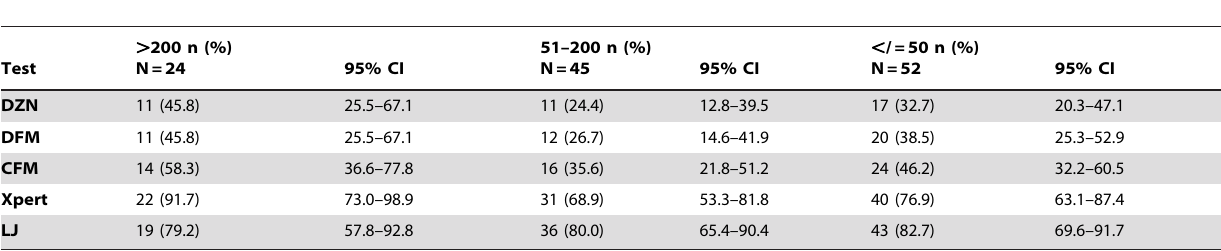
Table 5. Sensitivity per test by CD4 cell count among MGIT confirmed TB cases (n= 121).